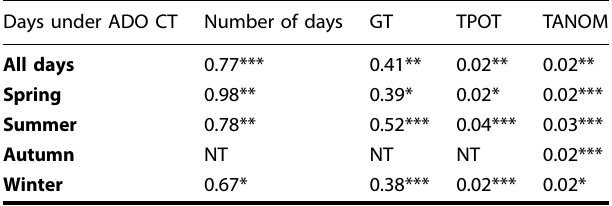
Table 1. Trend analysis for days under any ADO CT for the 1948 – 2020 period.